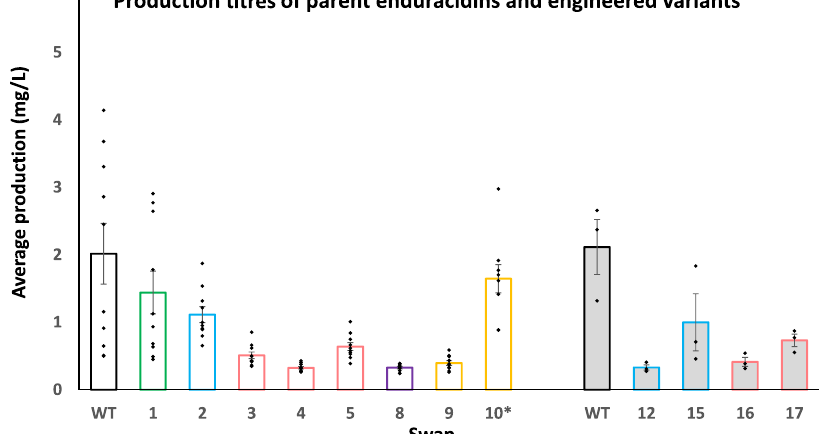
Fig. 6 Titres of enduracidin analogues produced by FSD swap mutant. Production levels (mg/L) for engineered enduracidin from FSD swaps compared with the wild type enduracidin ( 1a & 1b ). Non- fi lled bars represent a batch of ten replicates ( n = 10) for Swaps 1 – 5 and Swaps 8 – 10. Shaded bars represent a different batch of cultures carried out in triplicate ( n = 3) for Swaps 12, 15, 16 and 17. Data are presented as mean values + / − standard error. Each data point is overlaid on the graph as a dot plot. The wild type strain is included in both batches as a positive control. The production for Swap 10 was calculated from an average of eight samples, omitting two statistical outliers from fl asks 1 and 5. The ratio of enduracidin a & b variants produced by wild type and engineered strains is variable and so the combined yields (a & b) are reported in each case to enable a clearer comparison of the productivity of each strain. Each bar is colour-coded for the analogues produced: green ( 2a & 2b ), blue ( 3a & 3b ), pink ( 4a & 4b ), purple ( 5a & 5b ) and yellow ( 6a & 6b ). Source data are provided with this